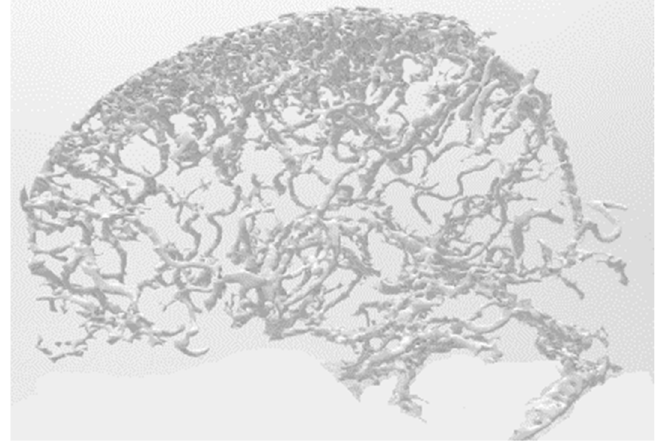
Figure 2. The hardware setup of the proposed system.